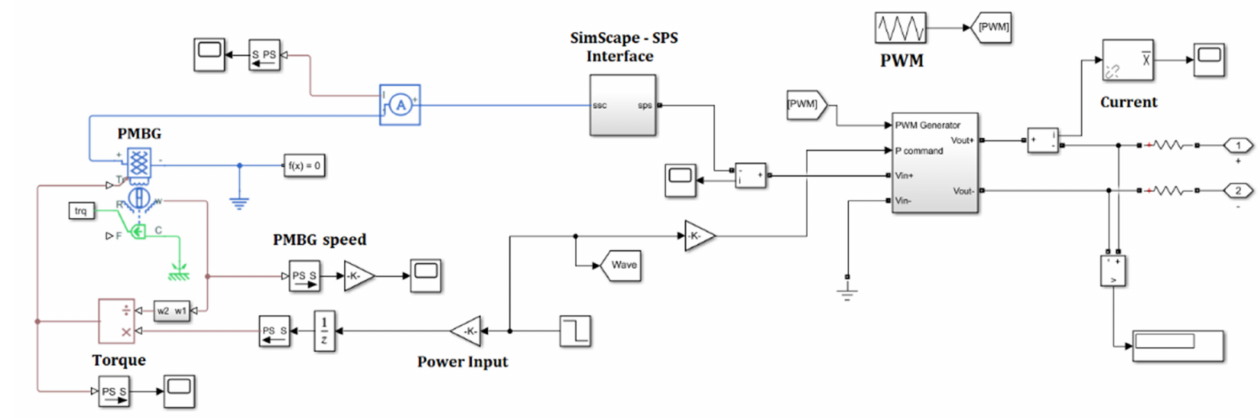
Figure 3. Wave Energy Converter (WEC) generator